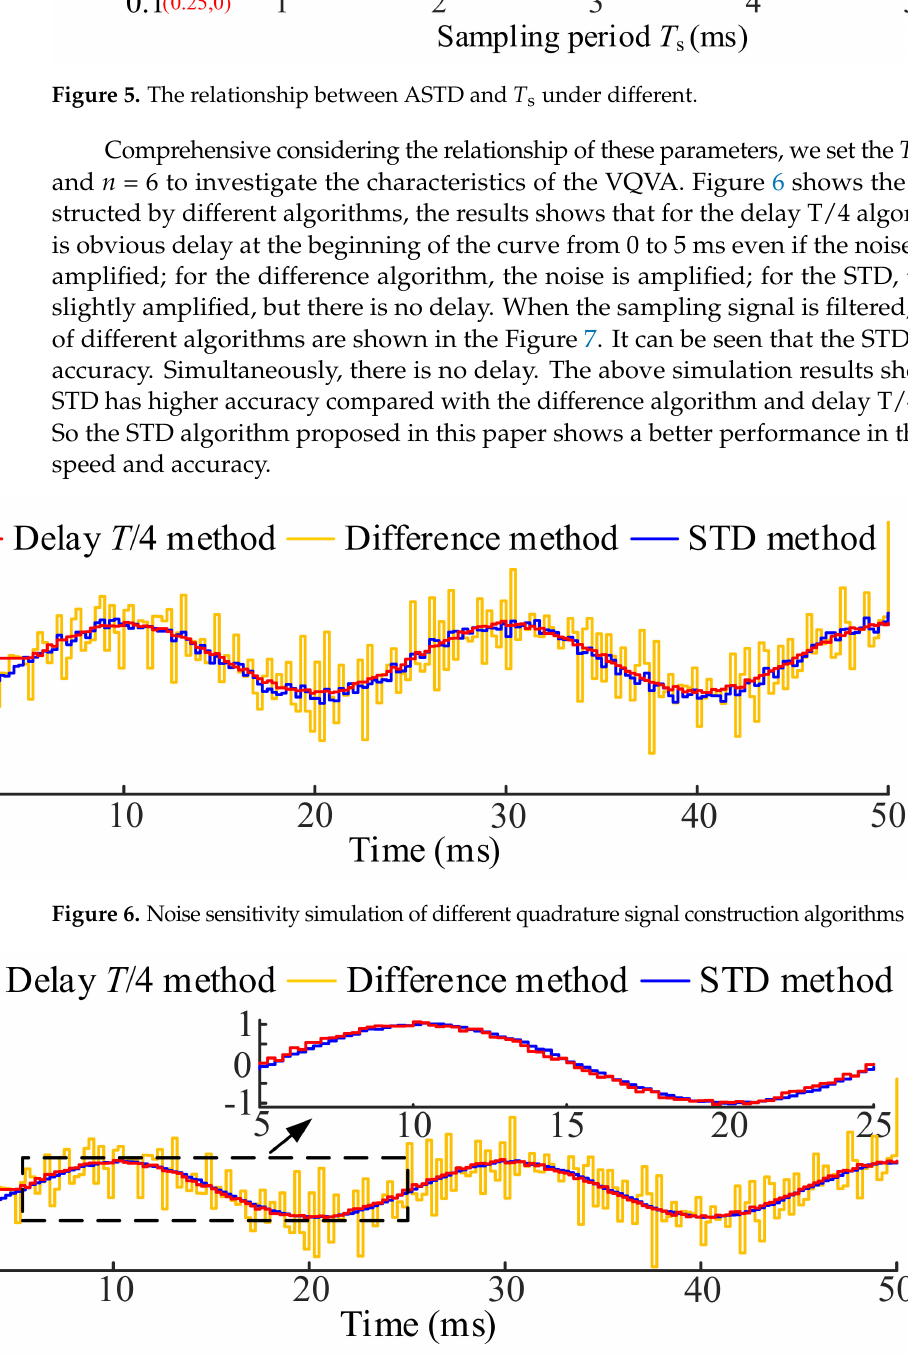
Figure 7. Noise sensitivity simulation of different quadrature signal construction algorithms with